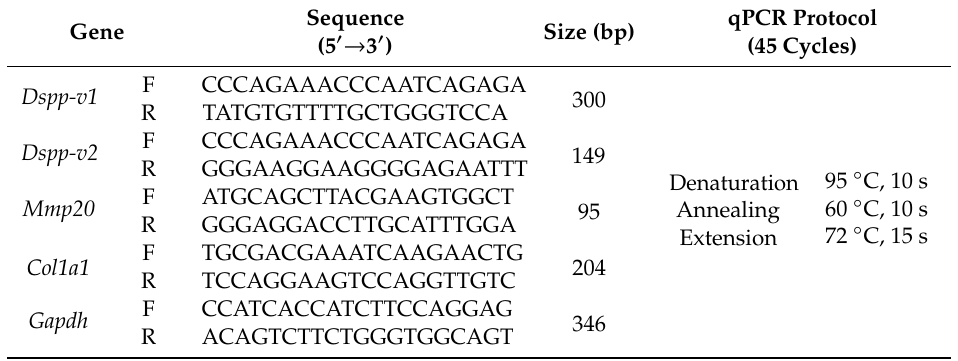
Figure A2. SEM observation of mineralized precipitates on MTA disk on day 14 cultured in the presence of LDN-193189. Each magnification and scale bar is shown in the figure. The photographs that are shown in the main Figure 9 are marked by red boxes. Table A1. Selected primers, size of amplified product for qPCR analysis shown in the main Figure